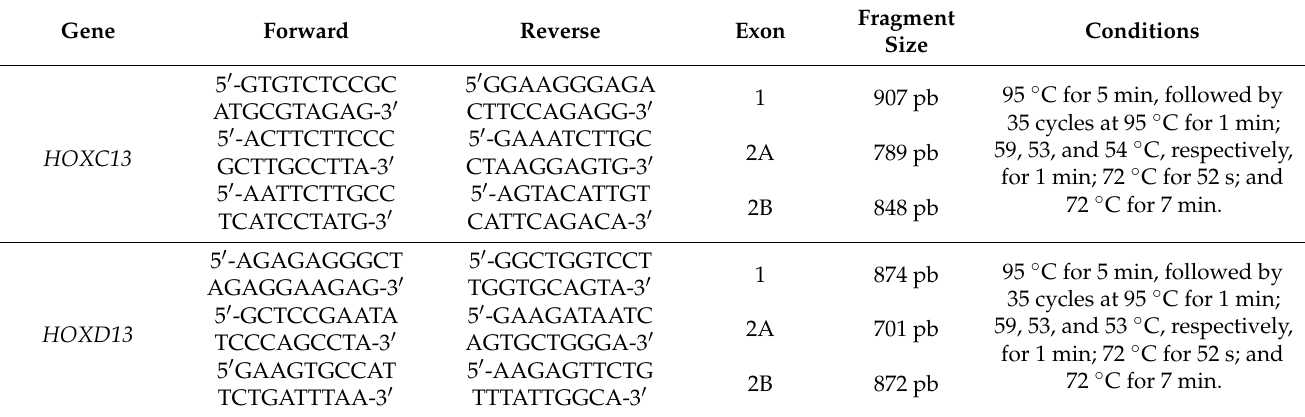
Table 1. HOXC13 and HOXD13